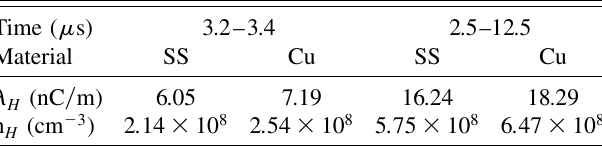
TABLE II. Calculated ionized gas densities immediately after the beam head ( 3 : 2 – 3 : 4 (cid:1) s ) and at the end of the beam pulse when intercepting the beam with stainless steel and copper